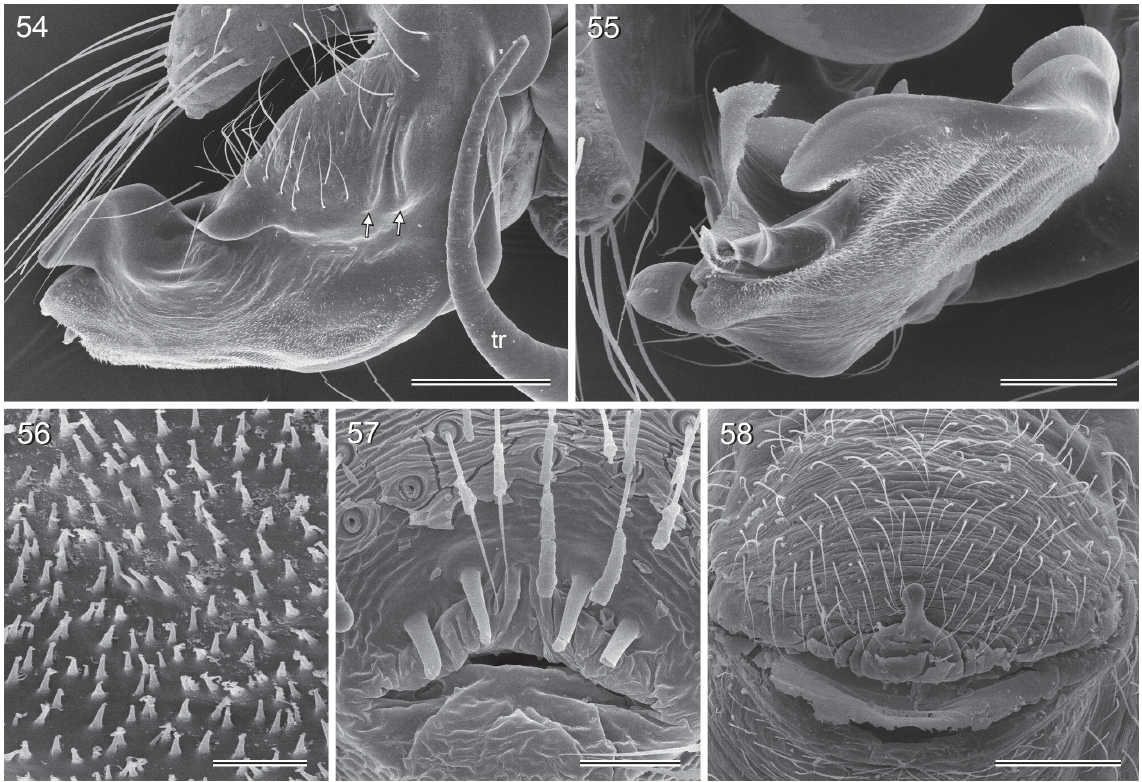
Figs 54–58. Pholcus ledang Huber, 2011, SeM micrographs (ZFMK, Ar 15704–05). 54 . Left procursus, retrolateral view. 55 . right procursus, distal view. 56 . Cuticular processes on whitish retrolateral area of left procursus. 57 . Male gonopore. 58 . Epigynum, ventral view. Scale bars: 54, 58 = 200 µm; 55 = 100 µm; 56 = 10 µm; 57 = 30